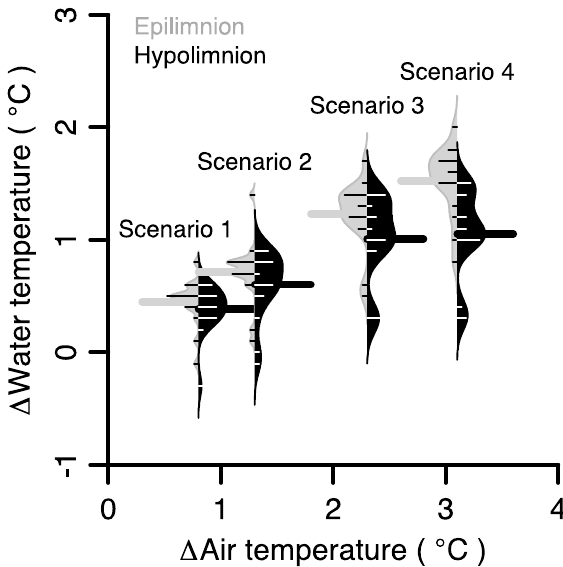
Figure 7. Bean plot showing changes in modeled water temperature for warmer scenarios relative to the reference run with no change. Bean lines inside a bean show frequency of observation points, bean areas show distribution as a nonparametric Gaussian kernel density shape, and bold lines show the mean in the distribution. Data from low water years (2002 to 2004) were excluded given that the study reservoir did not stratify then.